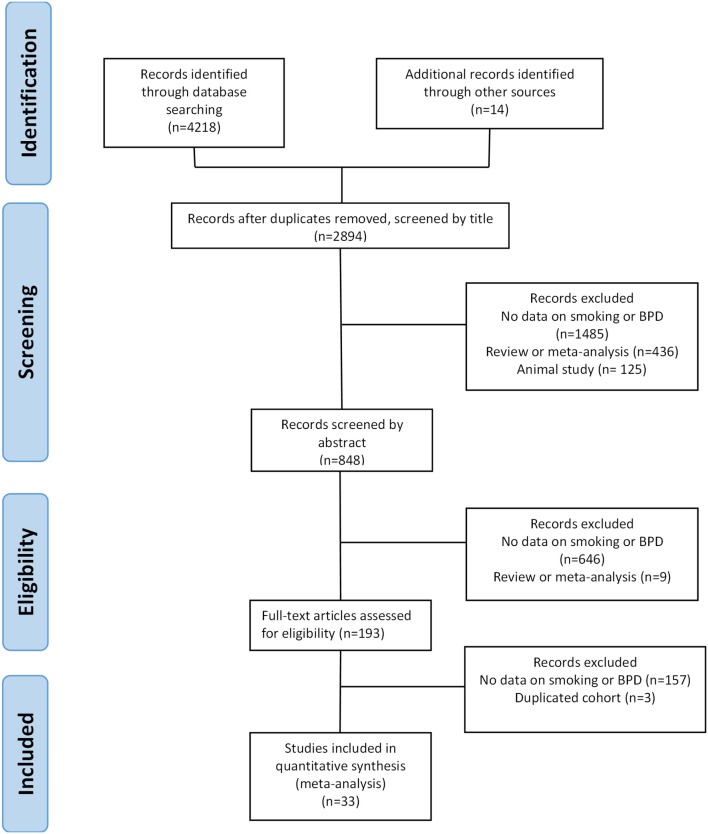
PRISMA diagram of the systematic search.